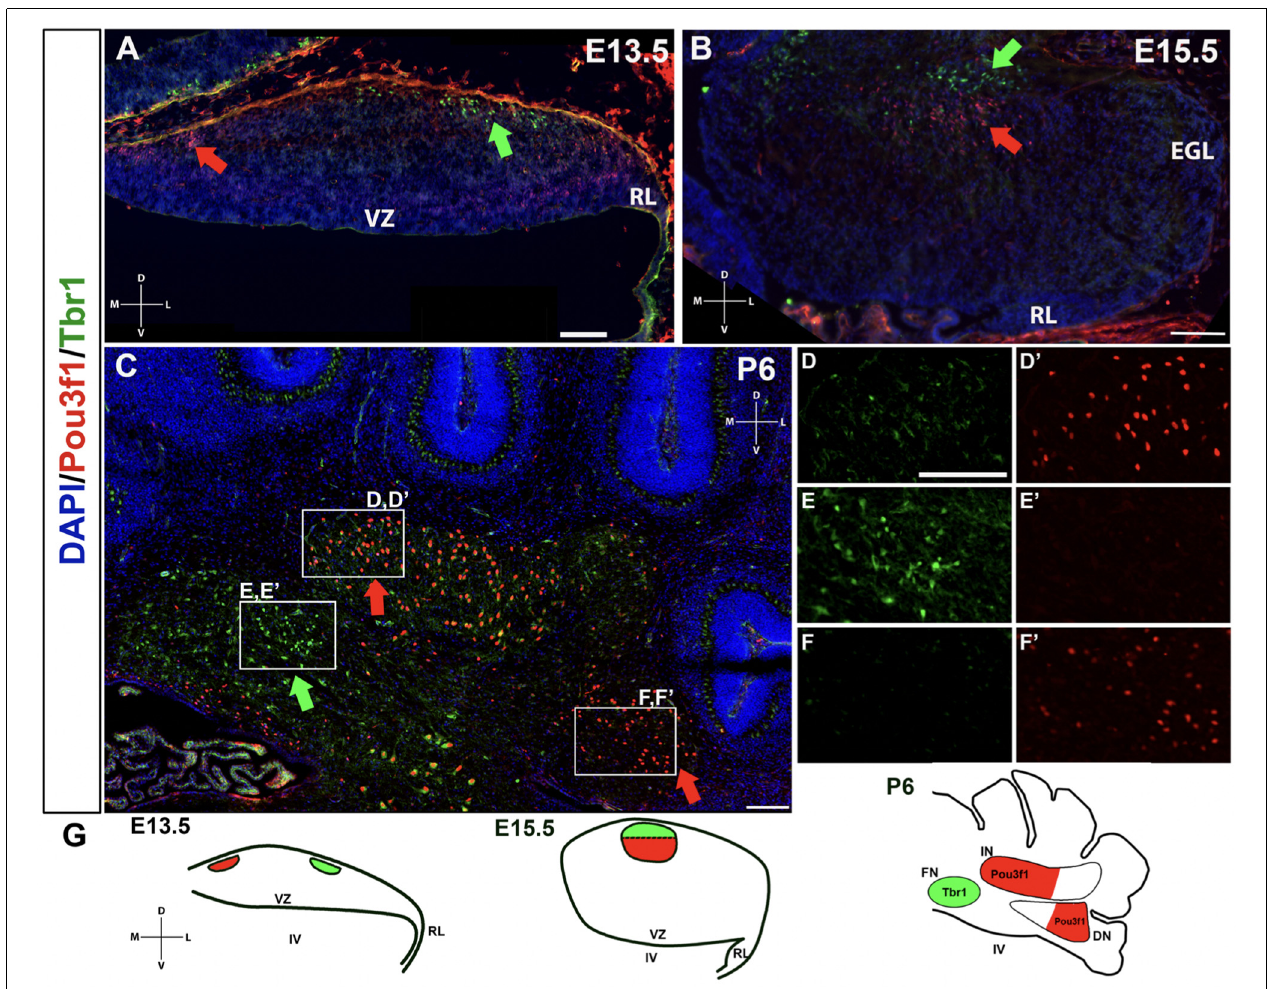
FIGURE 6 | The non-overlapping expression patterns of Pou3f1 and Tbr1 throughout development. (A) In the E13.5 wild-type cerebellum (coronal view), Pou3f1-expressing cells are located more medially than Tbr1-expressing cells (red and green arrows, respectively). (B) By E15.5, as shown in the wild-type cerebellum (coronal view), Pou3f1 + CN neurons and Tbr1 + CN neurons are found in the same plane along the medial-lateral axis (red and green arrows, respectively). However, the Pou3f1 + CN neurons tend to cluster more ventrally compared to Tbr1 + population. (C) At P6, the cluster of Pou3f1-labeled CN neurons is found more laterally than the Tbr1-labeled cluster (red and green arrows, respectively), with the former residing primarily in the interposed and dentate nuclei (D,D’,F,F’) , while the latter residing in the fastigial nucleus (E,E’) . Panels (D–F’) show boxed areas in (C) in higher magnification. (G) Schematic diagrams illustrating the migration patterns of Pou3f1 + (red) and Tbr1 + clusters (green) during cerebellar development. DN, dentate nucleus; D, dorsal; EGL, external germinal layer; FN, fastigial nucleus; IN, interposed nucleus; L, lateral; M, medial; NTZ, nuclear transitory zone; RL, rhombic lip; V, ventral; VZ, ventricular zone. Scale bars, 100 µ